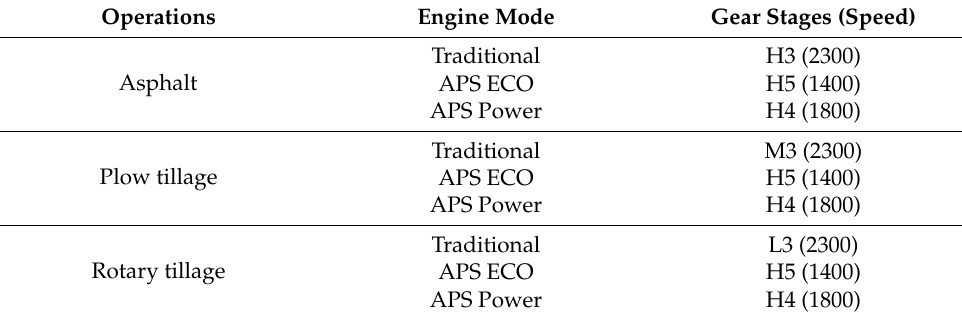
Table 3. The experimental operation conditions of a partial PST tractor.